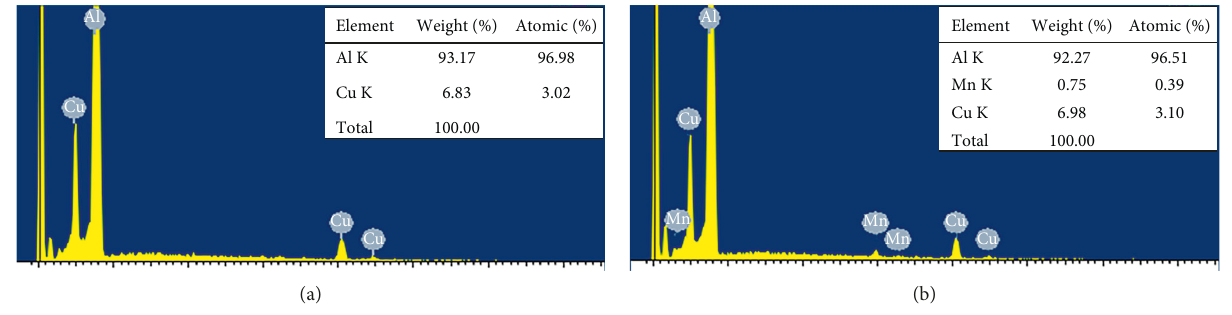
Figure 9: EDS results of the regions marked by Arrow 2 (a) and Arrow 3 (b) in Figure 2(a).